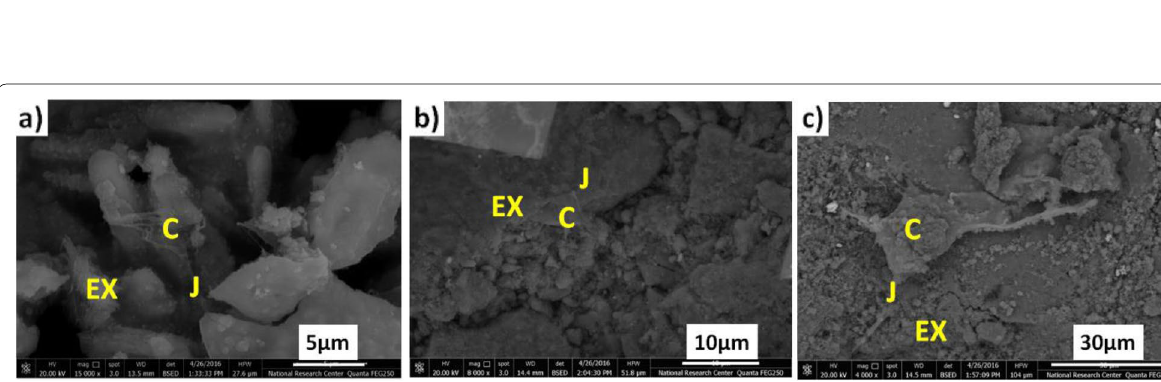
Fig. 8 SEM images for cells attachment on the surface of ceramic nanocomposite. a C1, b C2, and c